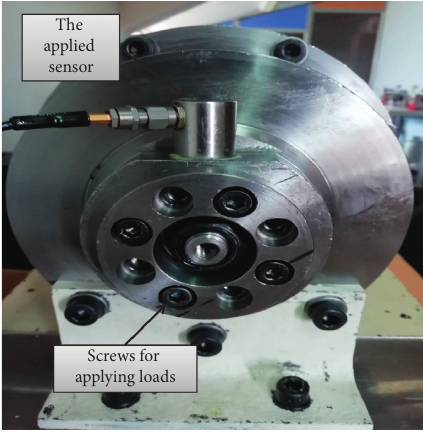
Figure 6: The applied sensor and loading system and